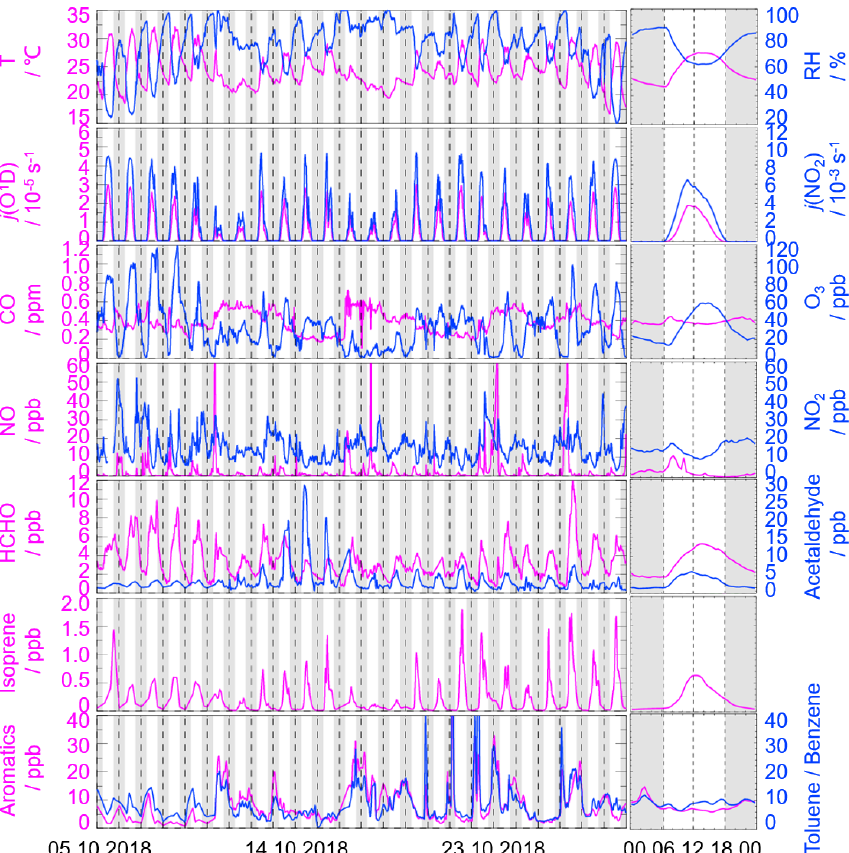
Figure 2. Time series and diurnal profiles of the observed meteorological and chemical parameters in the STORM campaign. The grey areas denote nighttime. The time of day in each figure is given in Chinese standard time (CST = UTC +